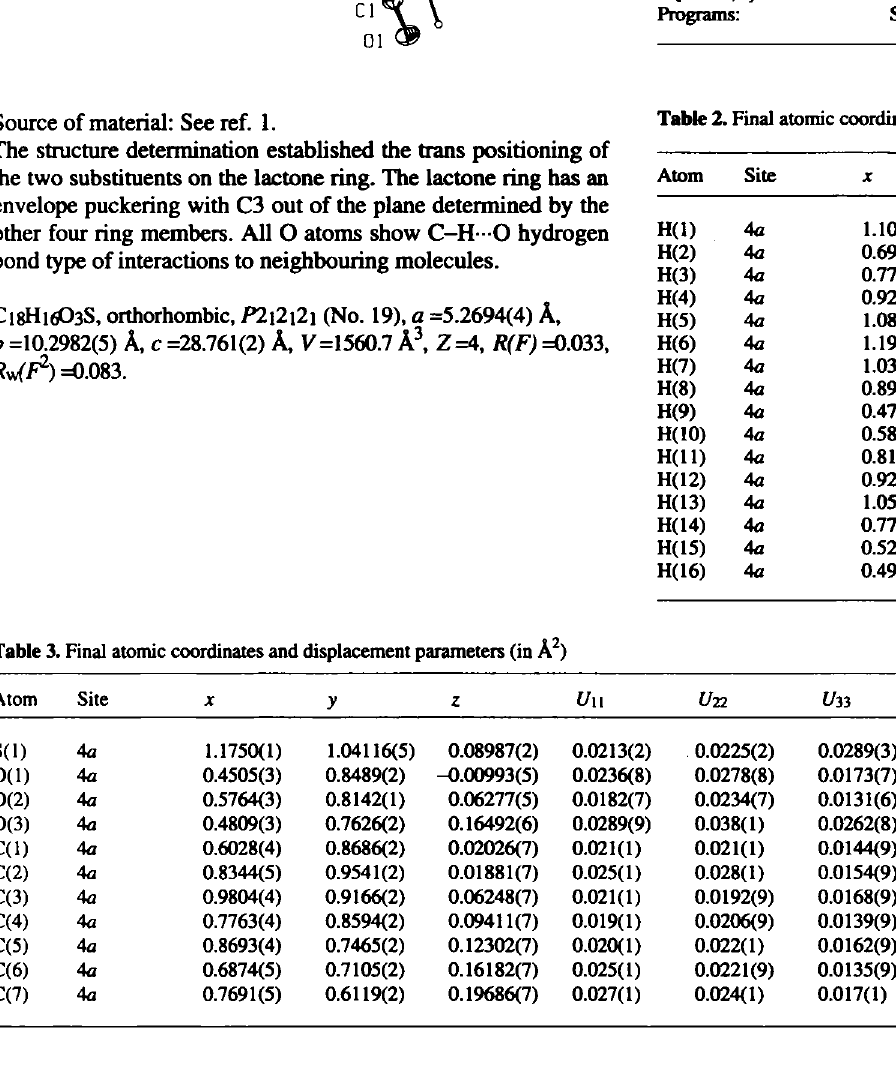
Table 2. Final atomic coordinates and displacement parameters (in Â 2 )